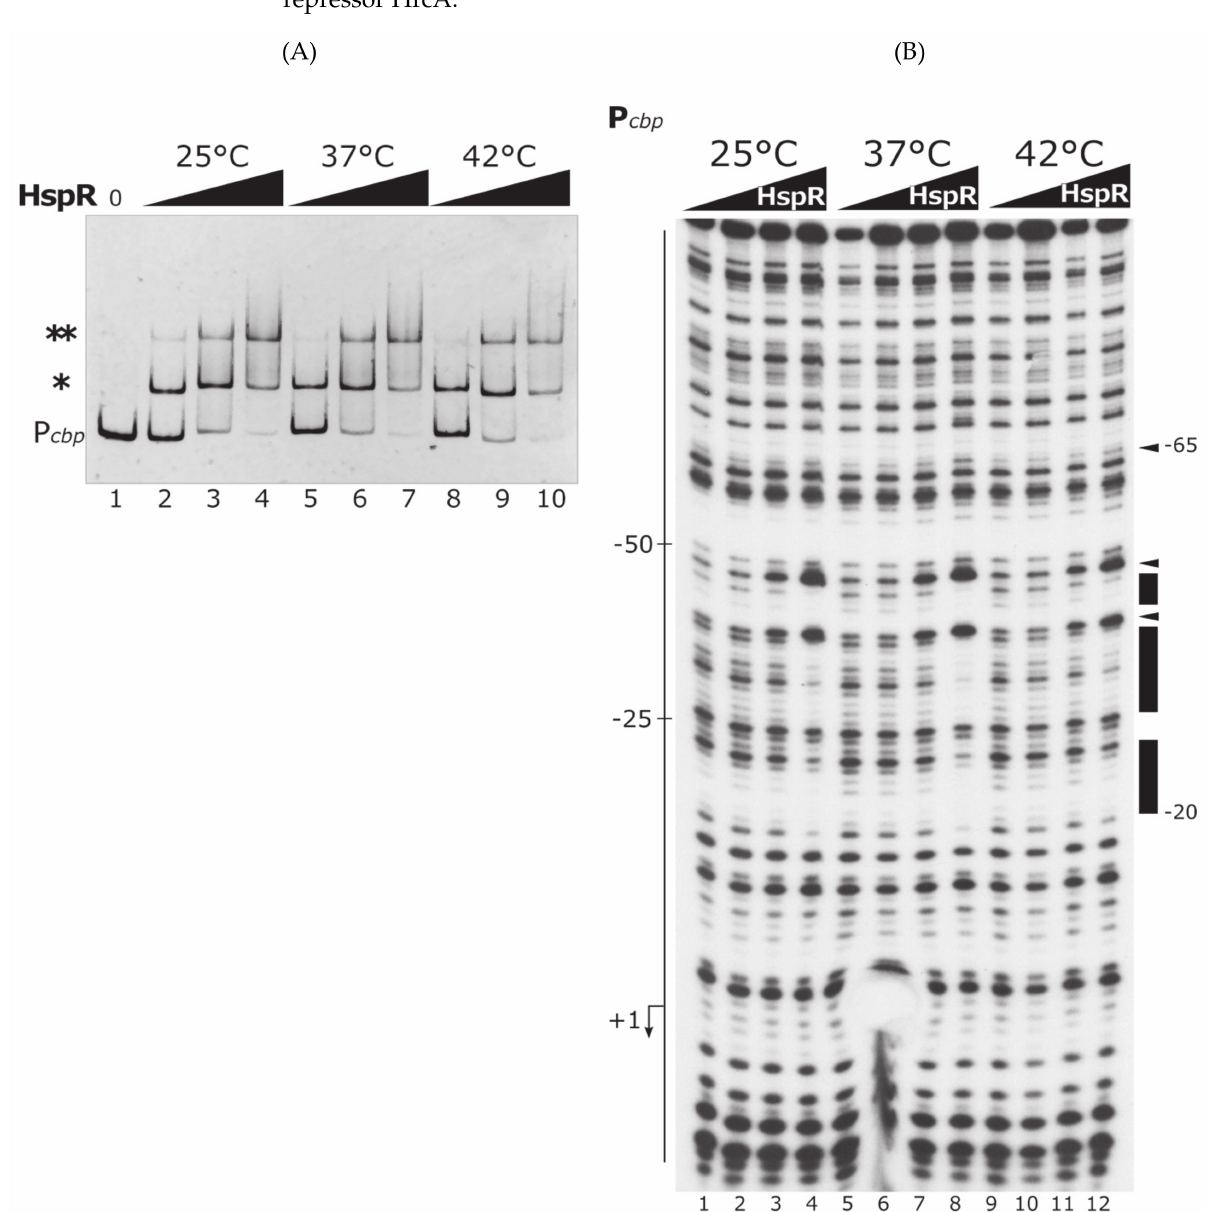
Figure 4. DNA-binding experiments of HspR to the P cbp promoter at different temperatures. ( A ) EMSA carried out with purified HspR on P gro promoter probe. DNA–protein complexes were allowed to form for 10 min at 25 ◦ C, then reactions were moved to different temperatures (25, 37 or 42 ◦ C) for 10 min. On the left, asterisks (* and **) mark the different HspR shifted bands, while the label “P cbp ” indicates the free probe. Lanes 1–4 contain 0, 15, 30 and 60 nM HspR, respectively. Lanes 4–6 and 8–10 contain the same increasing concentrations of HspR as in samples 2–4. Black triangles indicate increasing amounts of HspR at the indicated temperatures; 0, no protein added. ( B ) DNase I footprinting assays with HspR on P cbp labeled probe at different temperatures. Protein–DNA mixes were incubated for 10 min at 25 ◦ C, then shifted to different temperatures (25, 37 or 42 ◦ C) for 10 min, before DNase I cleavage. Lanes 1–4, 5–8 and 9–12 contain 0, 30, 60 and 120 nM HspR, respectively. On the left of the autoradiograph, the numbers refer to the positions with respect to the transcriptional start site (indicated by a bent arrow). Protected regions and DNase I hypersensitive sites are indicated on the right by black boxes and arrowheads, respectively, together with positions delimiting the HspR binding site. Black triangles are as in panel A. Symbols * and ** mark HspR shifted